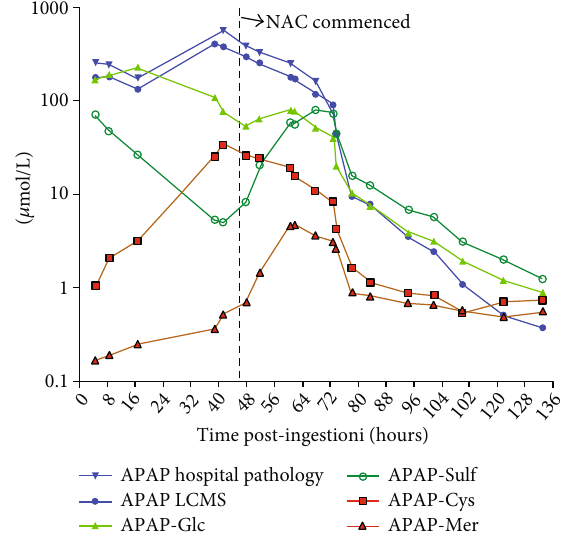
Figure 2: Acetaminophen and metabolite concentrations vs. time